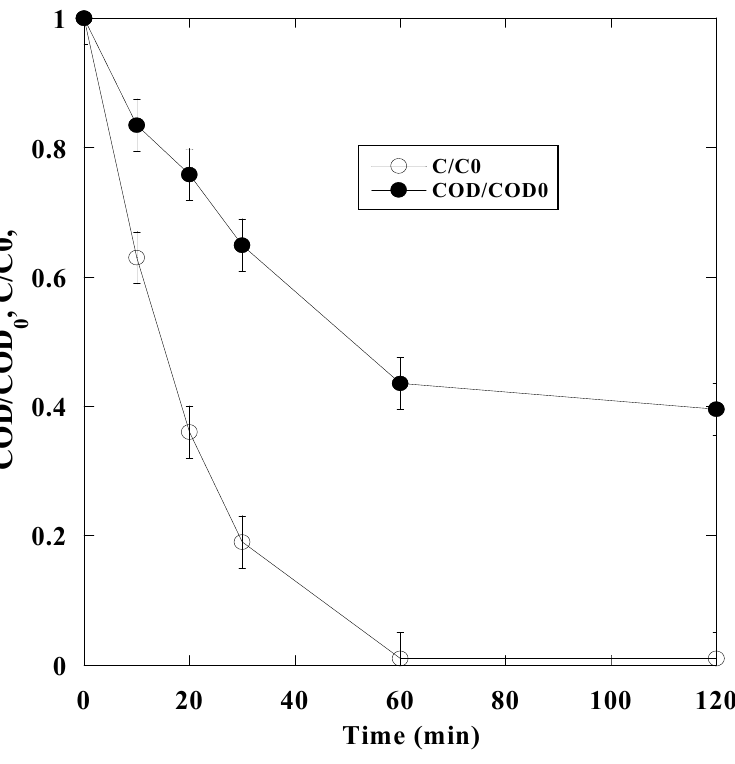
Figure 15. Removal of AO10 and measuring COD levels using the photoactivated periodate ([AO10] 0 = 50 mg/L, 20 ± 1 °C, [IO 4– ] = 3 mM, irradiation intensity: 15 mW/cm²).